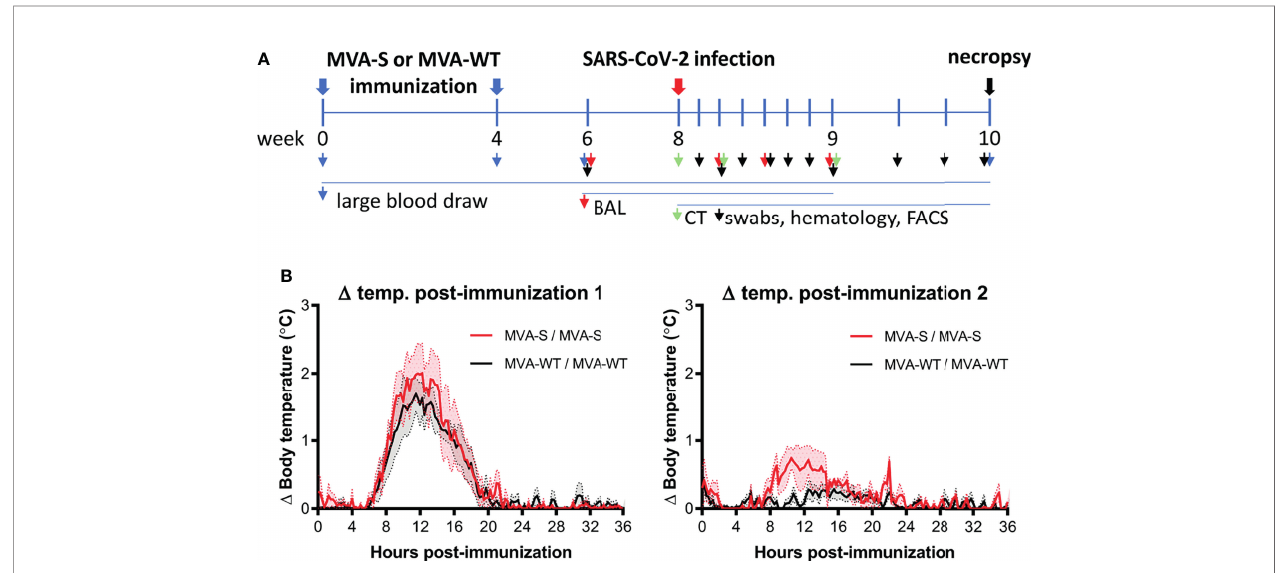
FIGURE 1 | Immunization schedule in rhesus macaques. (A) Rhesus macaques (n = 6 per group) were immunized at weeks 0 and 4 by the intramuscular (i.m.) route with two doses of 2 × 10 8 PFUs of MVA-S vaccine or control MVA-WT virus, as indicated (blue arrow). At week 8, all animals were challenged intranasally plus intratracheally with 1 × 10 6 TCID 50 of SARS-CoV-2 (red arrow). At different timepoints before and after challenge, diverse types of samples were taken, as indicated by arrowheads. All animals were sacri fi ced at days 15 or 16 post-challenge (black arrow). (B) Body temperature increase after the fi rst (left) and second (right graph) immunization. Averages and standard error of the mean (SEM) (shaded area) are presented per group. Body temperature was recorded every 15 min. Normal 24-h body temperature before immunization (mean of 8 – 14 days before immunization) was subtracted from post immunization body temperature of each individual